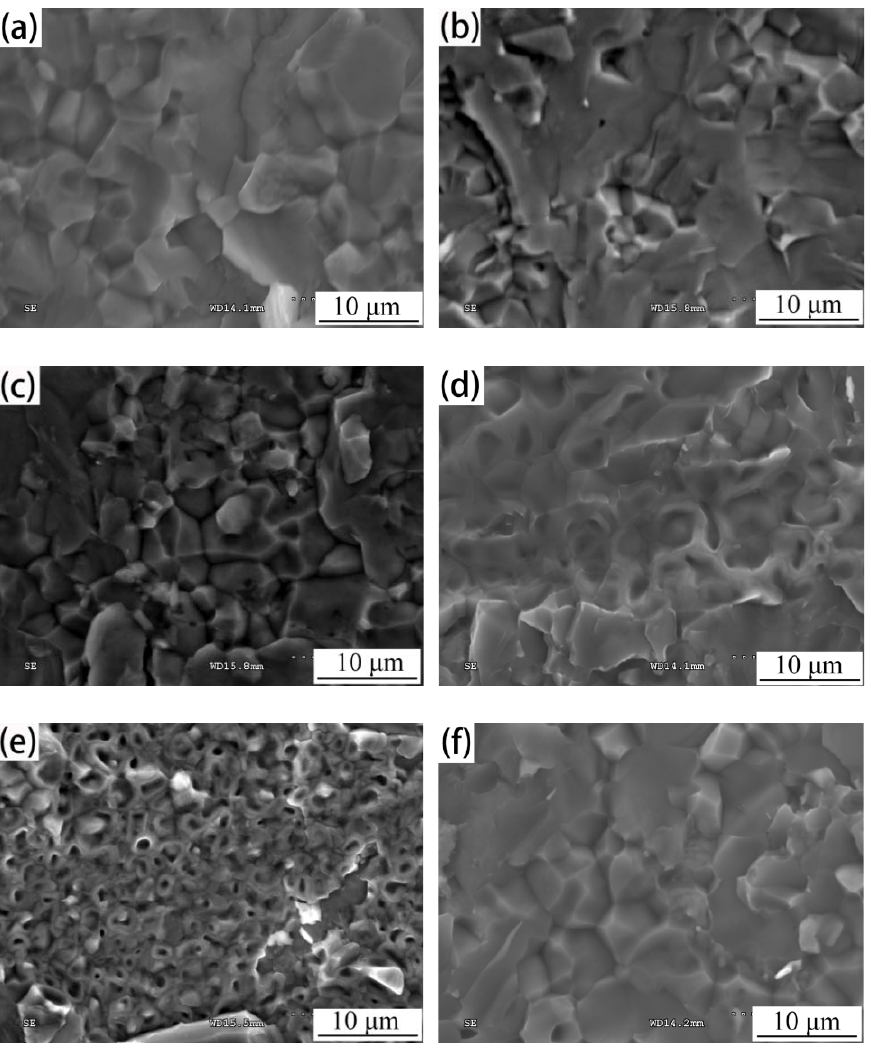
Figure 17. Fractography of at Cu side 1035 Al / Cu joints brazed by: ( a ) Zn-2Al; ( b ) Zn-5Al; ( c ) Zn-12Al; ( d ) Zn-15Al; ( e ) Zn-20Al; and ( f ) Zn-25Al.